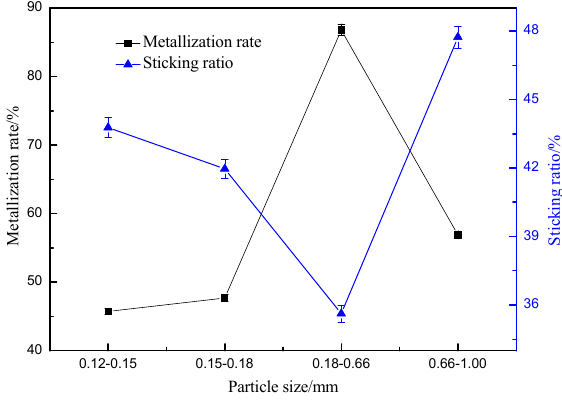
Figure 6. Trend of the metallization rate and sticking ratio with changing particle sizes when the OMC fine iron ore is reduced by pure carbon monoxide at 0.2 MPa, 1023 K, 0.8 m/s after 35 min.